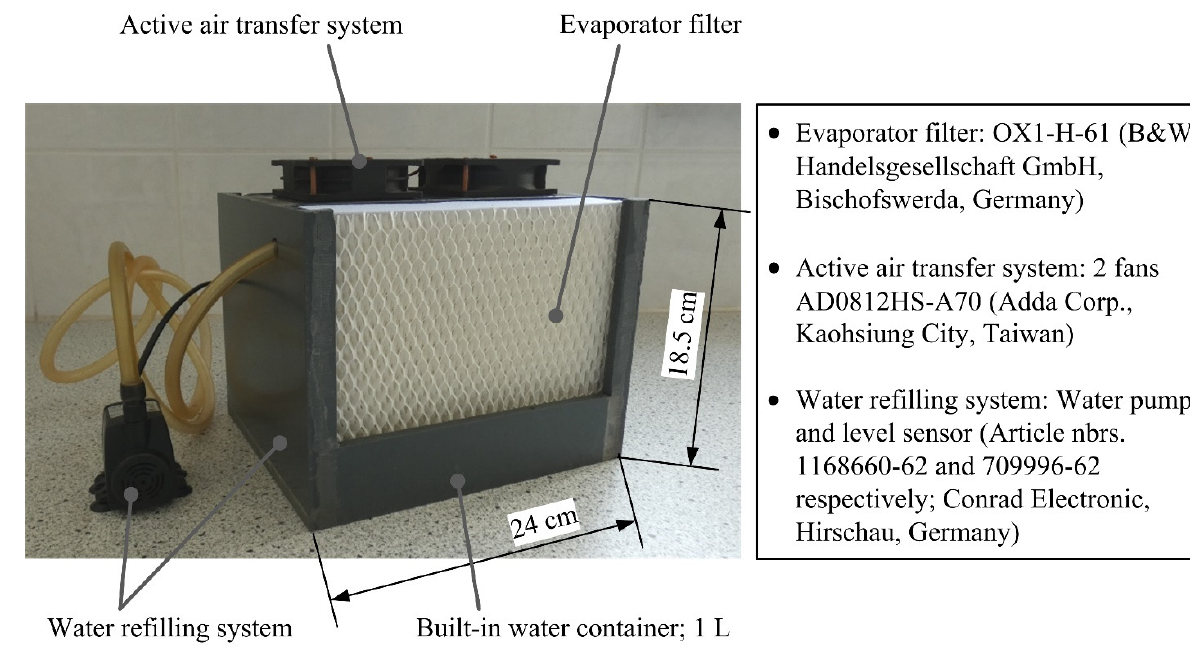
Figure 3. Humidifier used in the set-up of trial T3 and details of the components.